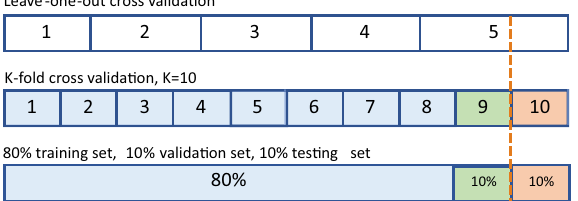
Figure 4. Different dataset partition methods. Assuming the patient has 5 seizures in total, the top frame is the leave-one-out cross-validation, the 5 labeled rectangles correspond to the preictal segment of 5 different seizures. The samples are split as K-fold and 8:1:1 respectively in the following two frames, where K is 10 in this